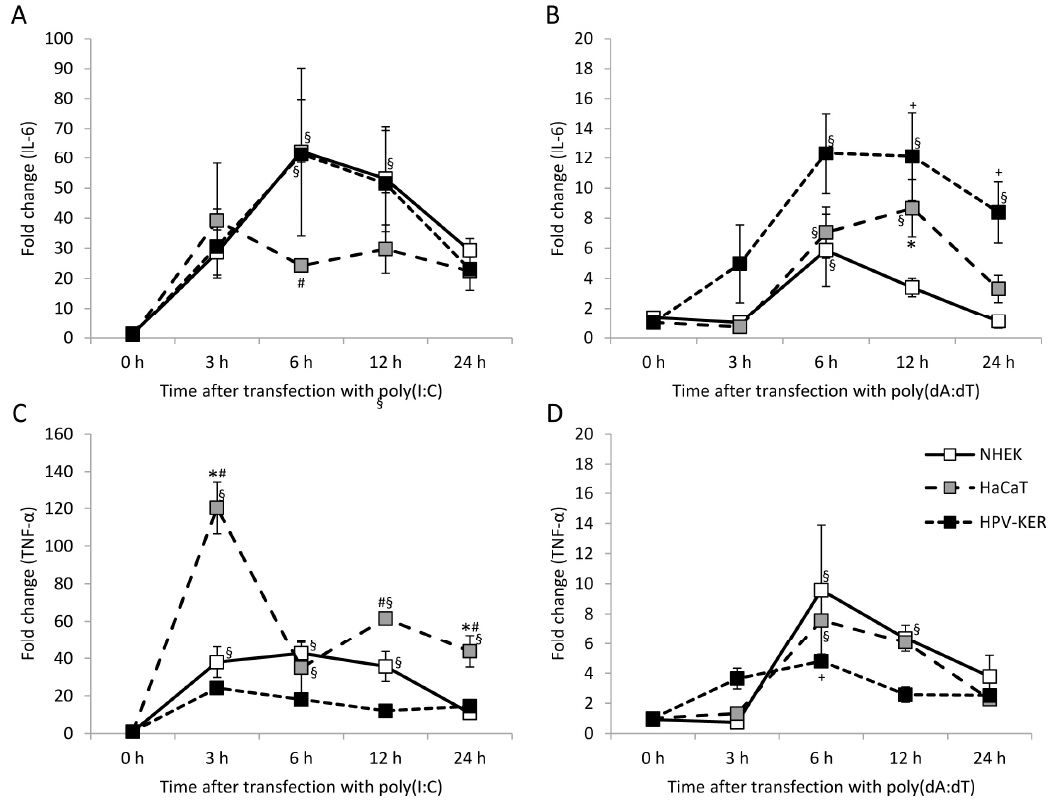
Figure 1. Kinetics of expression of the interleukin-6 (IL-6) and tumor necrosis factor α (TNF- α ) cytokines in normal human epidermal keratinocytes (NHEK) and HaCaT and HPV-KER cell lines upon transfection with 0.666 μ g/mL poly(I:C) ( A , C ) and poly(dA:dT) ( B , D ). Relative expression was determined by the ΔΔ C t method, normalized to 18S rRNA expression and compared to the expression of the untreated 0 h samples. Data are presented as mean of three independent experiments ± standard error. Significance was determined by two-way repeated measurement analysis of variance (ANOVA), * p < 0.05 HaCaT vs. NHEK; # p < HaCaT vs. HPV-KER; + p < 0.05 HPV-KER vs. NHEK; § p < 0.05 vs. 0 h samples within a cell type.